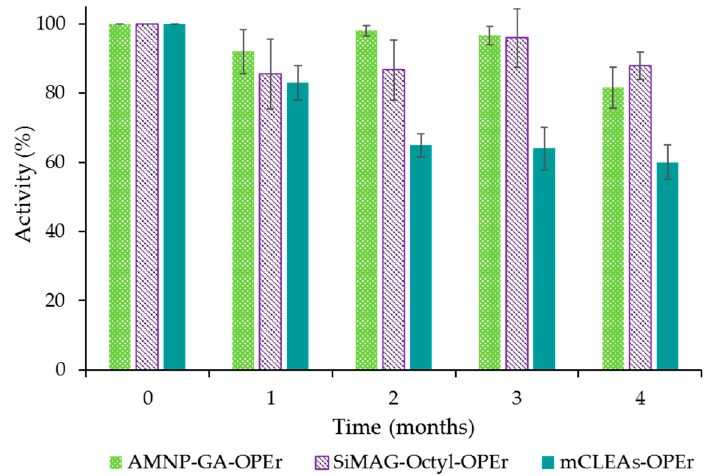
Figure 2. Activity of the three biocatalysts with immobilized OPEr, during storage for four months at 4 °C in Tris-HCl 20 mM pH 7, without stabilizers.